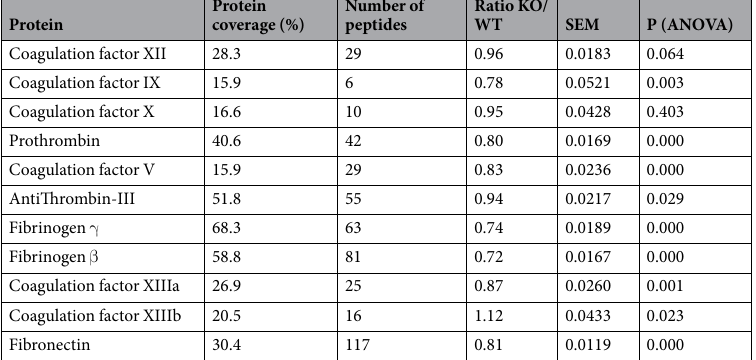
Table 1. Differentially regulated plasma proteins detected by proteomics.